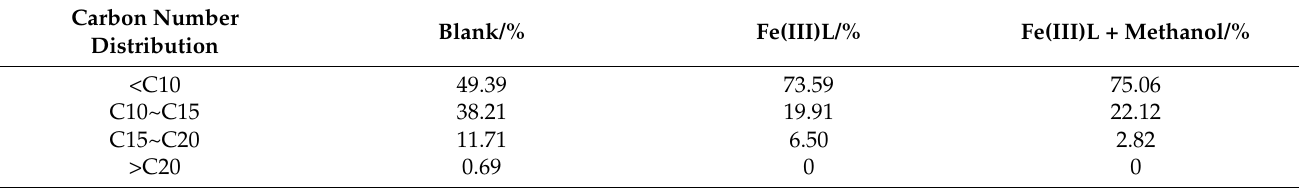
Table 2. Carbon number distribution of heavy oil before and after the reaction.